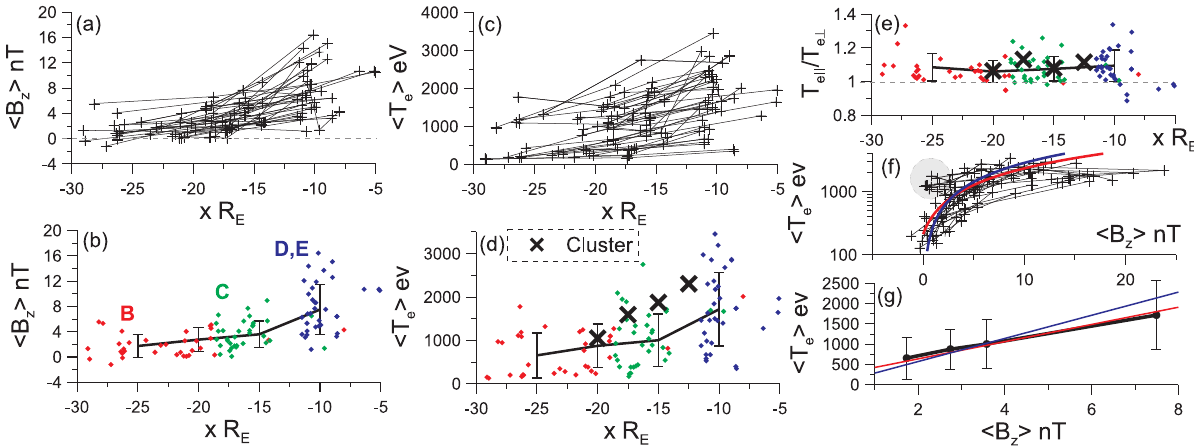
Fig. 3. h T e i , h B z i and h T k /T ⊥ i distributions in the magnetotail for 40 events, when THB, THC, and THD crossed the CS. Panels (a) , (c) , and (f) show all profiles of h T e i and h B z i from our database. In panels (b) , (d) , and (g) , we present average values of corresponding quantities with standard deviations. Panel (e) shows average values of electron temperature anisotropy. Various symbols (red, green, and blue diamonds) are used for data collected by THB, THC, and THD (THE) spacecraft. Black crosses show averaged data from Cluster C2 statistics. In panels (f) and (g) , color curves show approximations h T e i / h B z i ≈ 2keV / 7nT (red curve) and h T e i /( h B z i+ 1nT ) ≈ 1 . 7keV / 8nT (blue curve). See text for